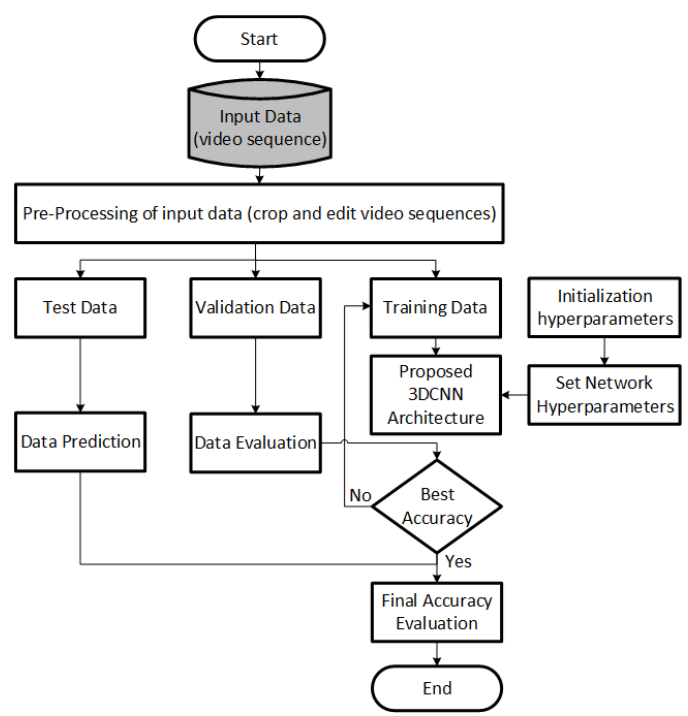
Figure 4. Surface graph of dependencies of the average accuracy of batch size and number of epochs.